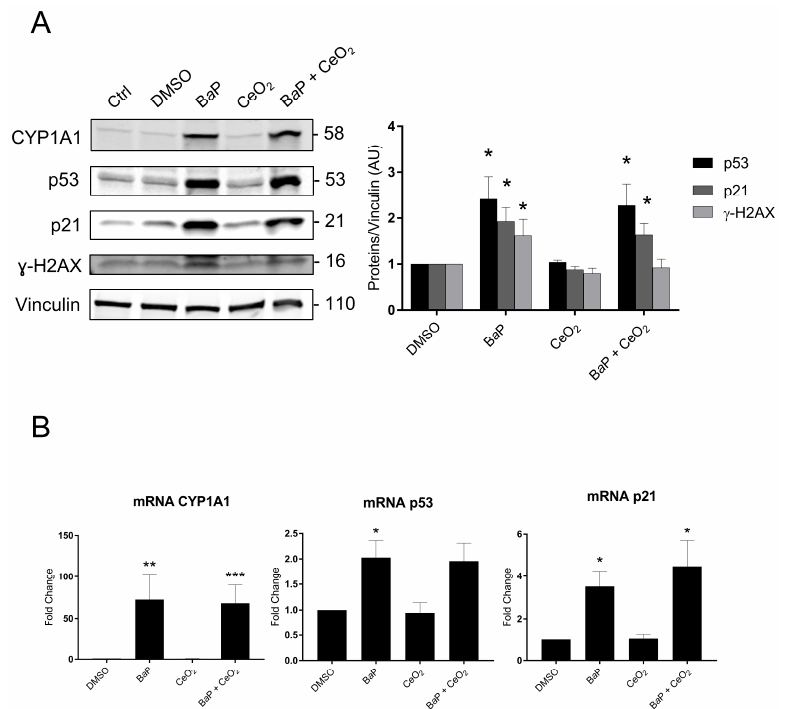
Figure 6. p53 signaling and DNA damage after trophoblast exposure to benzo(a)pyrene and/or cerium dioxide nanoparticles. VCT purified from term placentas were plated overnight and were untreated (control) or incubated with DMSO, B a P (1 µ M), and/or CeO 2 NP (10 µ g/cm 2 ) for 24 h. ( A ) Total protein extracts were subjected to SDS-PAGE under reducing conditions and membranes were immunoblotted with anti-CYP1A1, anti-p53, anti-p21, anti- γ H2AX, and anti-vinculin antibodies (loading control). Immunoblots were quantified with an Odyssey System Imager and the results represent the mean +/ − SEM after normalization to vinculin ( n = 6). * p < 0.05 vs. DMSO. ( B ) Total mRNA was extracted from VCT, followed by reverse transcription. Real-time quantitative PCR (RT-qPCR) was performed for the genes of interest CYP1A1, p53, and p21. The results, expressed as fold change, represent the mean +/ − SEM after normalization to the geometric mean of the reference genes HPRT, RPLO, and SDHA ( n = 5). * p < 0.05, ** p < 0.01, *** p < 0.001 vs. DMSO.